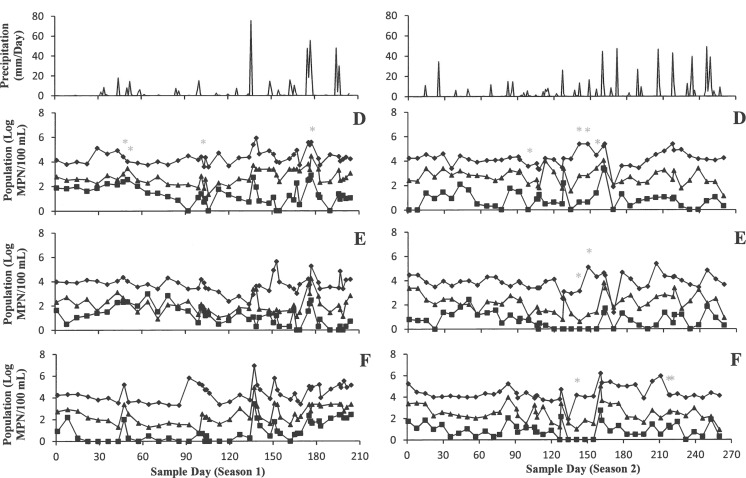
Most Probable Number of Total coliform (♦), Generic E. coli (■), and enterococci (▲) (Log MPN/100 mL) from six agricultural ponds (Pond 4: D, Pond 5: E, Pond 6: F) with daily rainfall (mm/Day) in Central Florida.invA positive sampling days were shown with “*”.